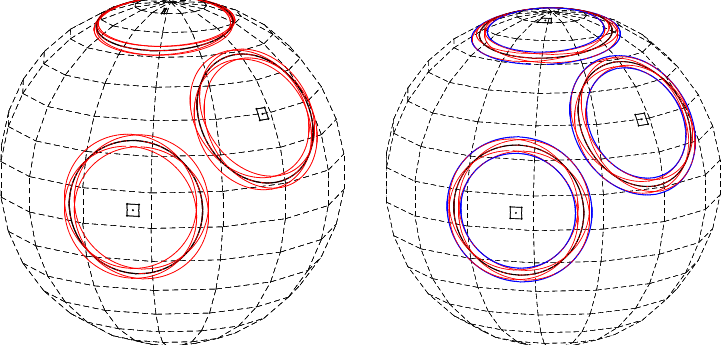
Figure 23. ( Left ) Cells corresponding to uniform quantization in the plane; cells close to the equator are larger than cells close to the poles. Corner circles (red) of cells closer to the pole are closer to each other than corner circles of cells closer to the equator. ( Right ) Almost-equal-sized cell quantization: all cells are of approximately the same size, so the spherical segments between the upper and lower critical circles (blue) cover similar areas.